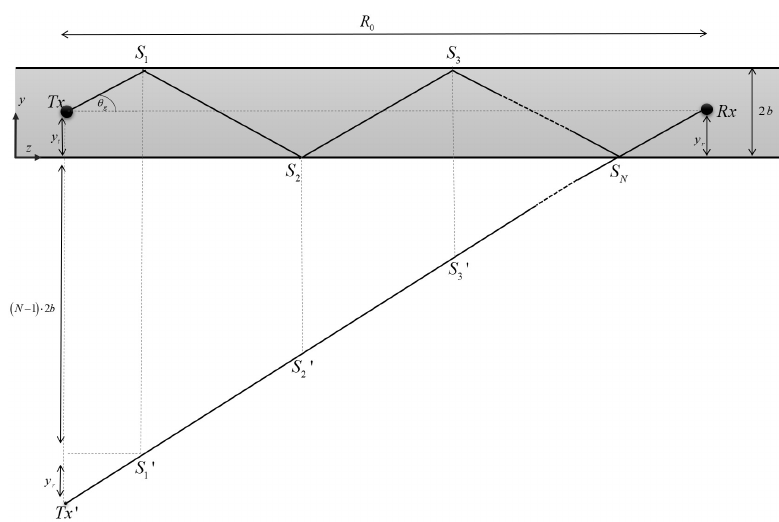
Figure 7. Demonstration of the image method used to derive the number of maximum rays